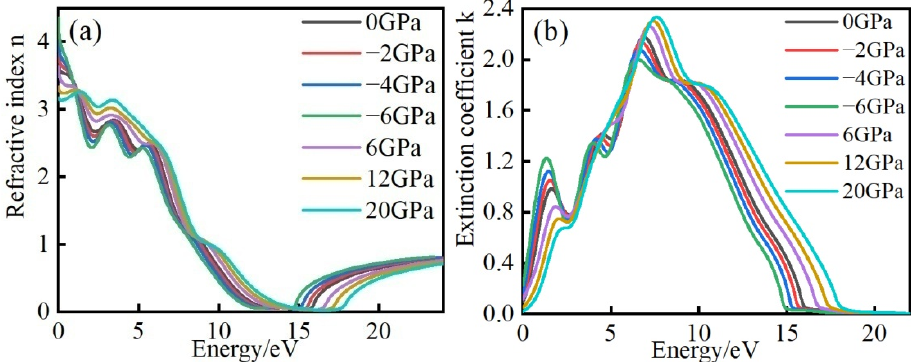
Figure 8. Complex refractive index for ( a ) the refractive index and ( b ) the extinction coefficient.